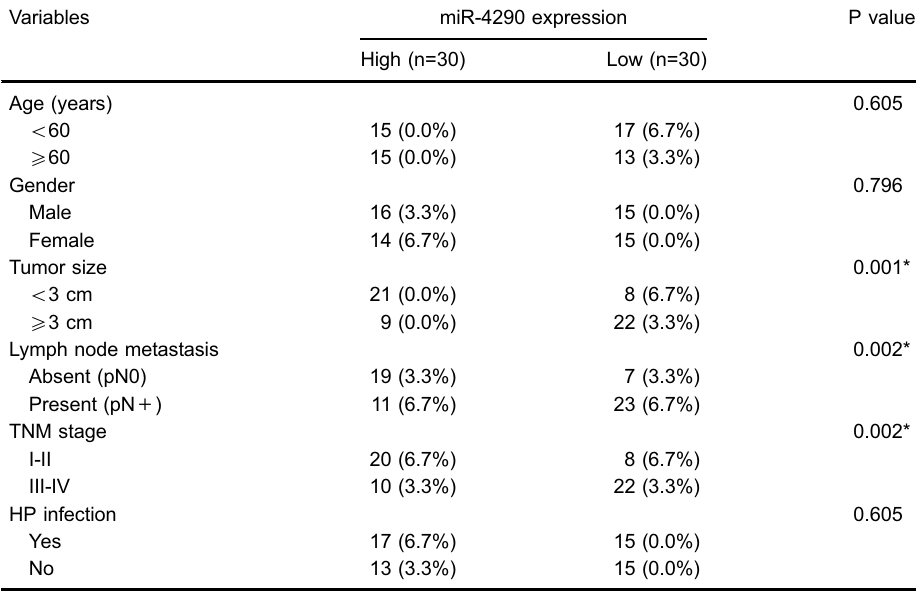
Table 1. Associations between miR-4290 expression and clinicopathological features in patients with gastric cancer.